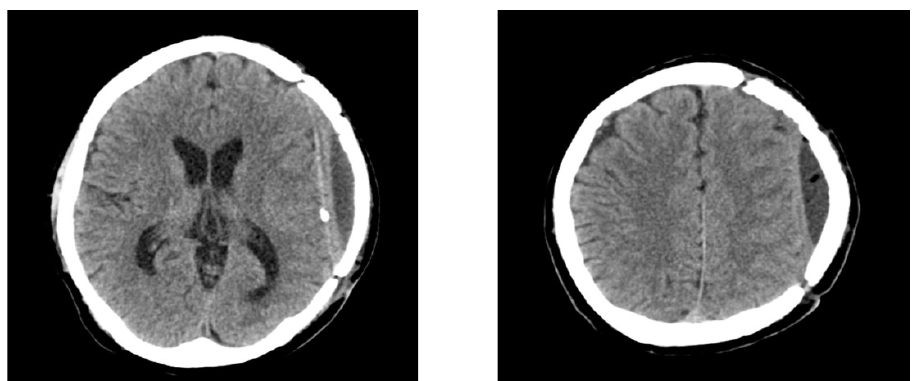
Figure 2. Brain computed tomography scans at 8 months after cranioplasty reveal improvement in